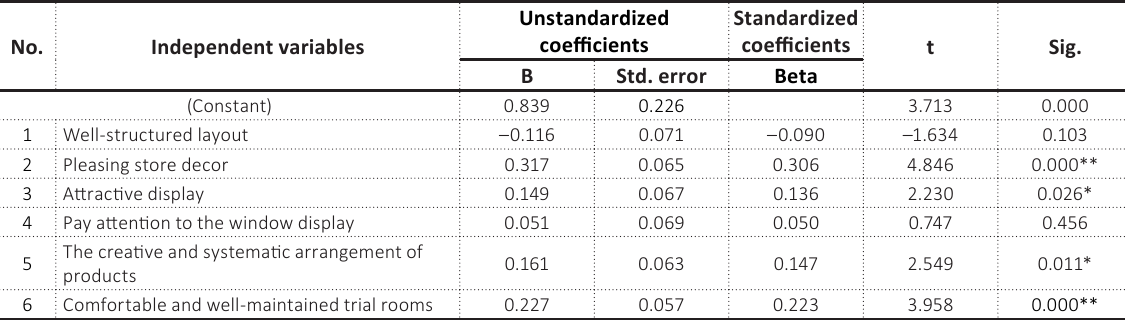
Table 9. Regression analysis of the impact of store layout on impulse buying behavior